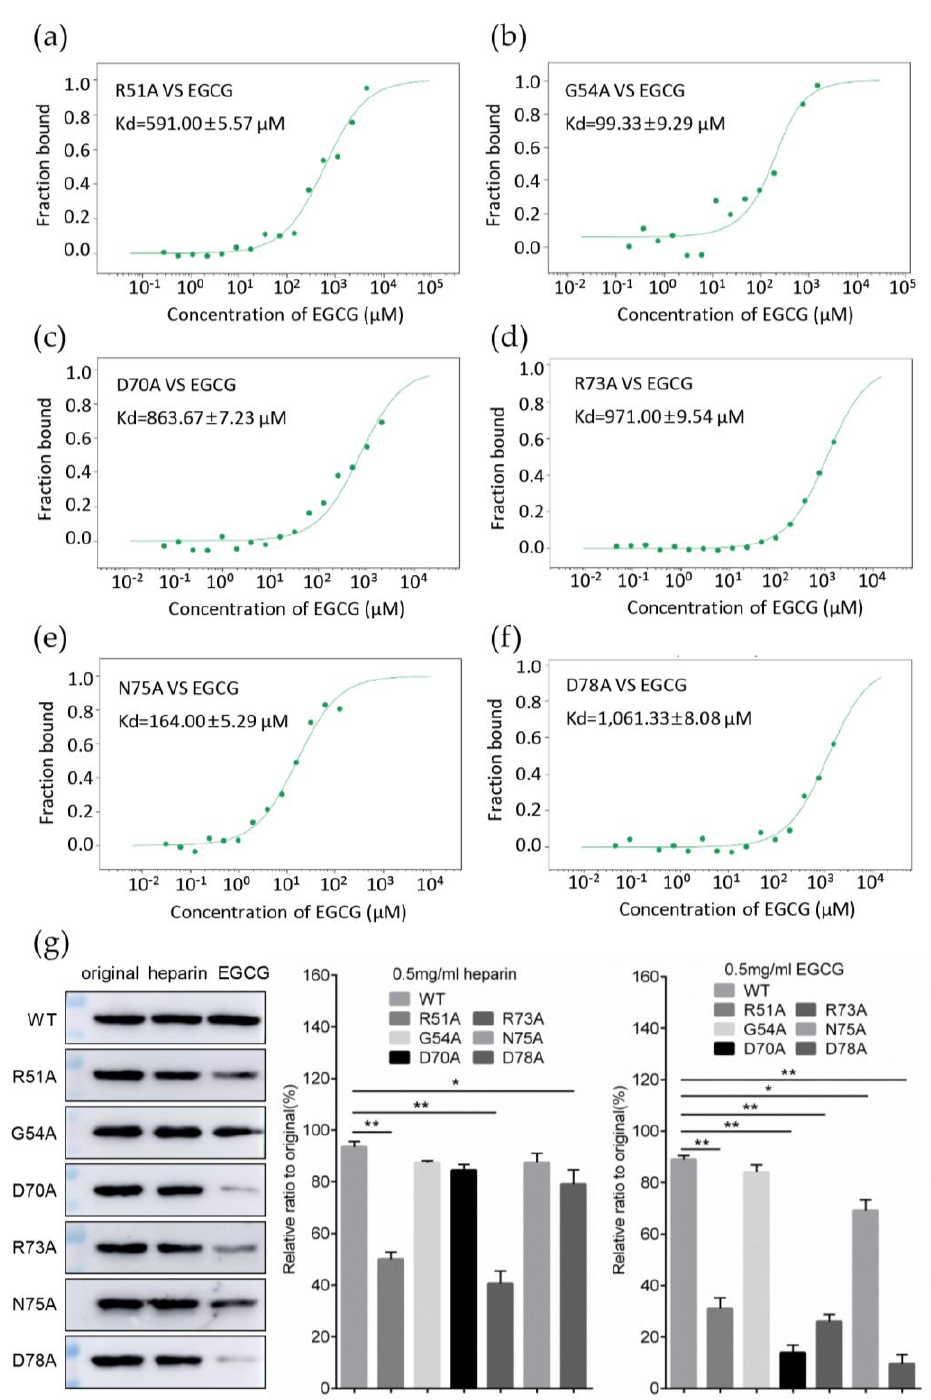
Figure 6. Verification of key amino acids involved in the interaction of EGCG with capsid. ( a – f ) The affinity impairment of capsid to EGCG induced by the key amino acid mutation. The Cy5 fluorophore labeled dcapsid mutants were incubated with two-fold serially dilutions of EGCG at room temperature for 15 min before being tested with MST, and the Kd values between EGCG and capsid mutants R51A ( a ), G54A ( b ), D70A ( c ), R73A ( d ), N75A ( e ) and D78A ( f ) were measured, respectively. ( g ) The eluted level of capsid mutants bound to the heparin column. Heparin column preloaded with dcapsid mutants was eluted with 0.5 mg/mL soluble heparin or EGCG. The eluted level of each mutants was analyzed using immunoblotting. Mean ± SD of three independent experiments were statistically analyzed using Student’s t -test (* p < 0.05; ** p < 0.01).